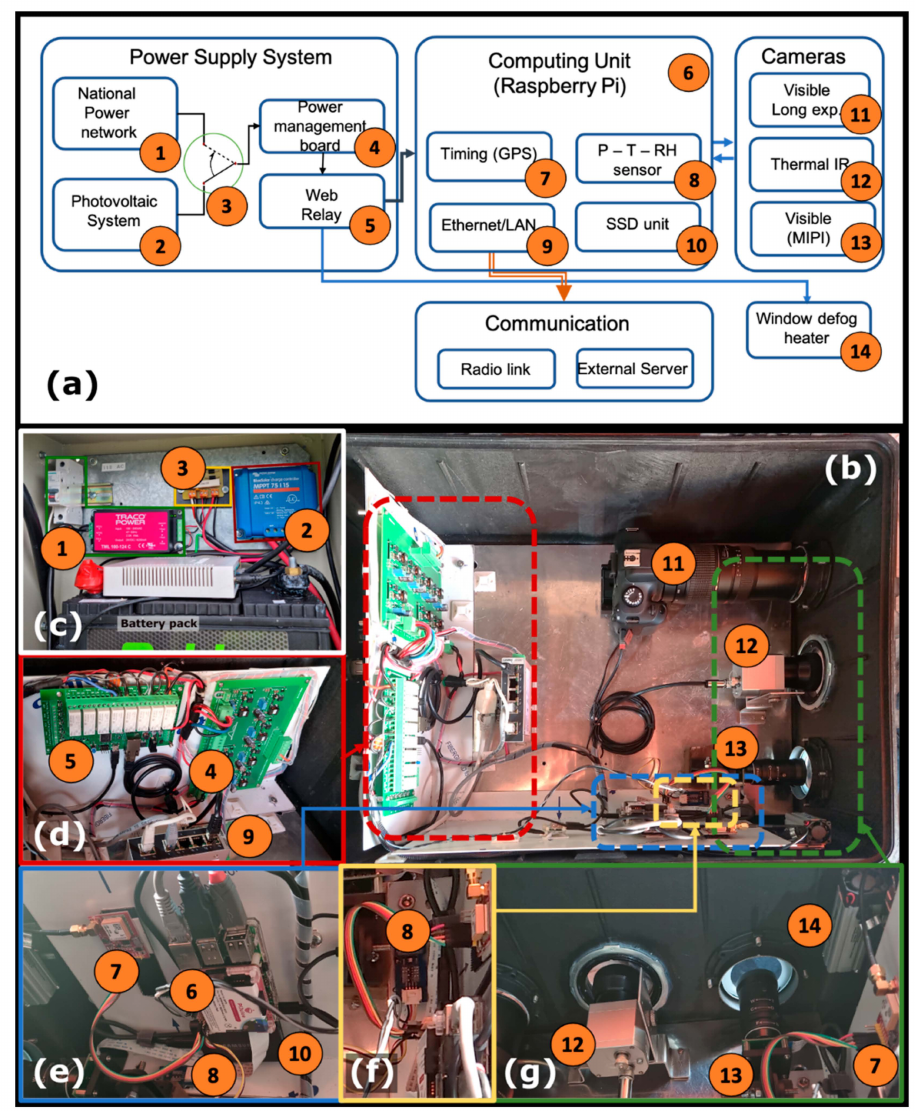
Figure 3. ( a ) Block diagram of the components of VIGIA. The physical disposition of the elements inside the case is shown in ( b ). Most of the elements composing the power system are physically placed out of the main case ( c ); those that remain inside are the power management board (4) and the web relay (5), shown in panel ( d ). Panel ( e ) contains the central computer (6) and its peripheric devices: (7) GPS module, (8) pressure–temperature–relative humidity (P-T-RH) sensor, (9) Ethernet hub and (10) solid state drive (SSD). A zoomed view of the P-T-RH sensor is displayed in panel ( f ). Panel ( g ) shows the disposition of the thermal camera (12), the visible camera (MIPI CSI) (13) and the window defog heater